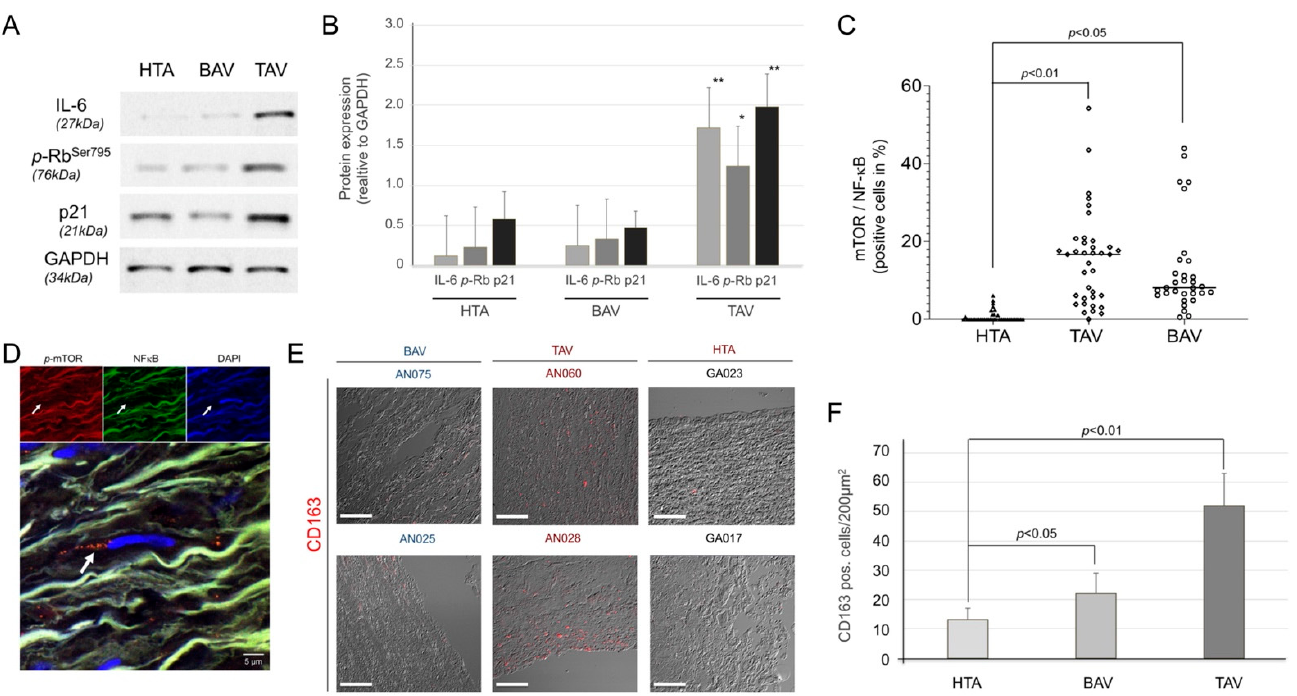
Figure 4. Senescence and SASP expression in healthy and diseased thoracic aortic tissue. Expression of cellular marker, a chemokine (IL-6), cell cycle regulatory proteins (Rb, p21), and SASP regulatory proteins (mTOR and NF- κ B). ( A ) Representative blot of IL-6, p-Rb, and p21 measured by Western blot, GAPDH was used as an internal control. Protein size is given in kilodaltons (kDa). HTA, human thoracic aorta; TAV, tricuspid aortic valve; BAV, bicuspid aortic valve. ( B ) Statistical analysis for protein expression detected by Western blot in HTA ( n = 13), compared to TAA-TAV ( n = 13) and TAA-BAV ( n = 13) specimens. Protein expression was calculated relative to internal control (GAPDH). * p < 0.05; ** p < 0.01. NF- κ B/ p -mTOR protein expression given as colocalization (white arrow) was detected by IF-staining. ( C ) Statistical calculations for HTA ( n = 24), TAV ( n = 37), and BAV ( n = 30)). A representative image of IF staining is shown ( D ). Red, p -mTOR; green, NF- κ B; blue, cell nuclei (DAPI). ( E ) Representative image of CD163 + macrophages detected in aortic and aneurysmal specimens. Scale bar, 100 µm. ( F ) Statistical calculations of CD163-positive cells/200 µm 2 in HTA, TAV, and BAV specimens.